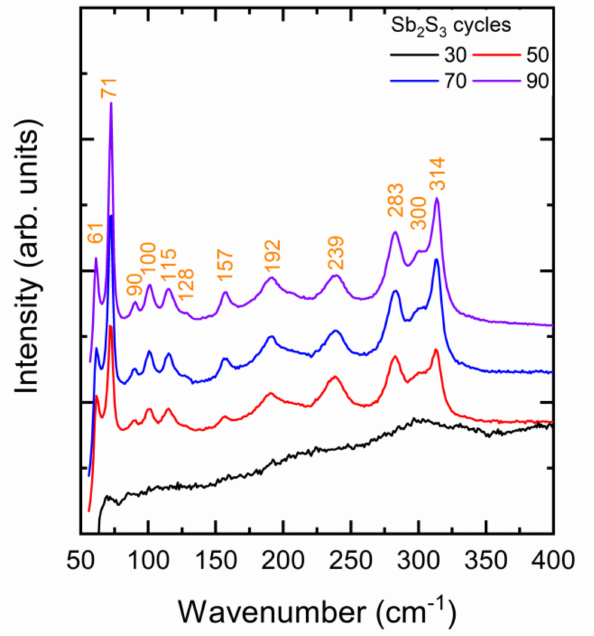
Figure 3. Raman spectra of ZnO/TiO 2 core–shell NW heterostructures covered with a Sb 2 S 3 shell grown by CSP using 30, 50, 70, and 90